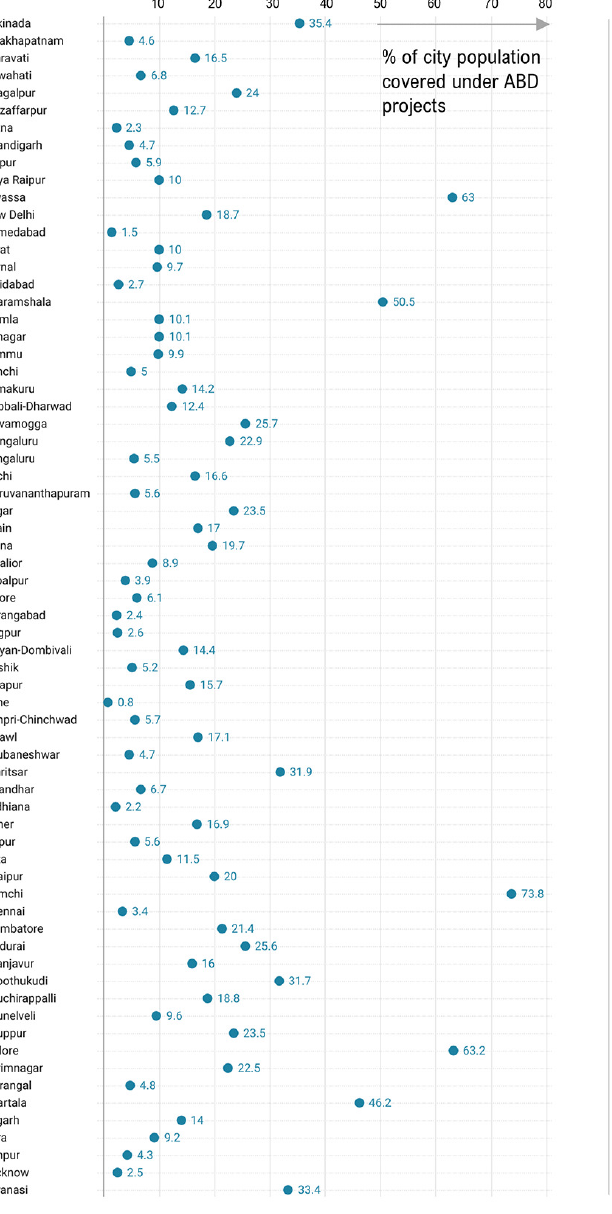
Figure 2. Quantification of the city area and population covered under the ABD